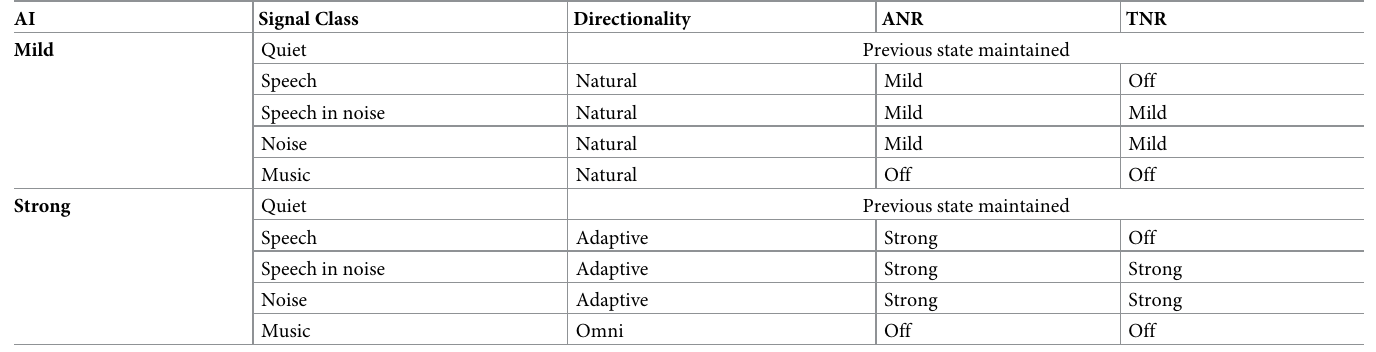
Table 1. Adaptive intelligence (AI) activation